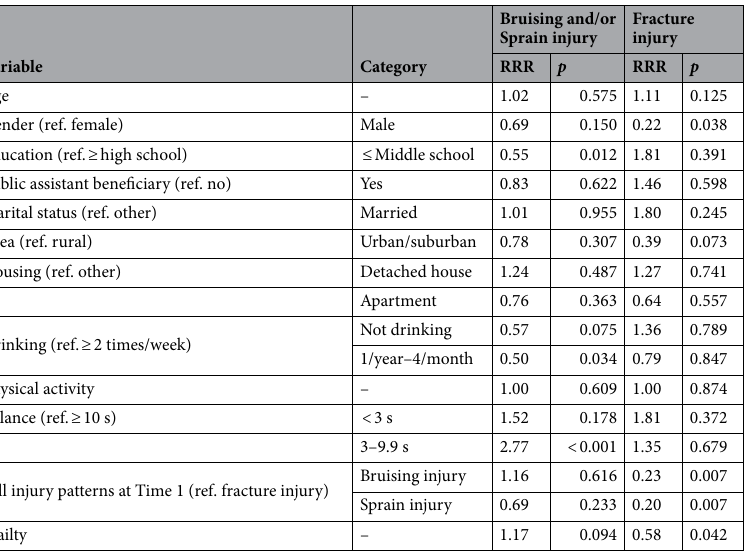
Table 6. Results of multinomial logistic regression analysis examining risk factors for fall injury patterns at Time 2. RRR, relative risk ratio; CI, confidence